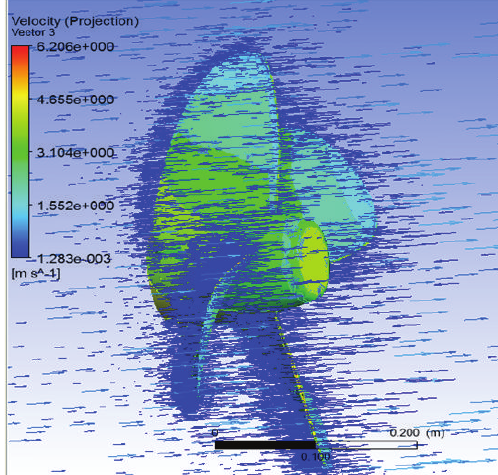
Figure 8: Contours of velocity (𝐽 = 1)